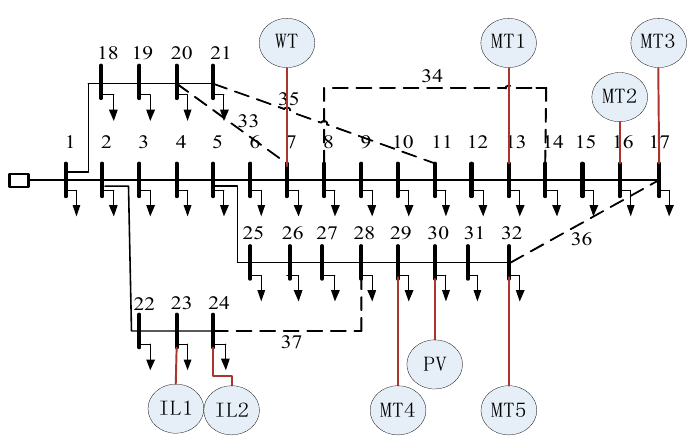
12 of 21 Figure 3. The flow chart of chance constrained programming (CCP). 5. Case Studies In this section, four cases will be introduced to demonstrate the benefits for coordination optimization of network reconfiguration and DER outputs, consideration of REG forecast errors and the hierarchical coordination optimization method, respectively. 5.1. Test System Specifications The improved IEEE 33 nodes distribution network [29] is adopted as the test system, shown as Figure 4. Each branch is equipped with a RCS. The maximum daily number of each RCS switching actions (